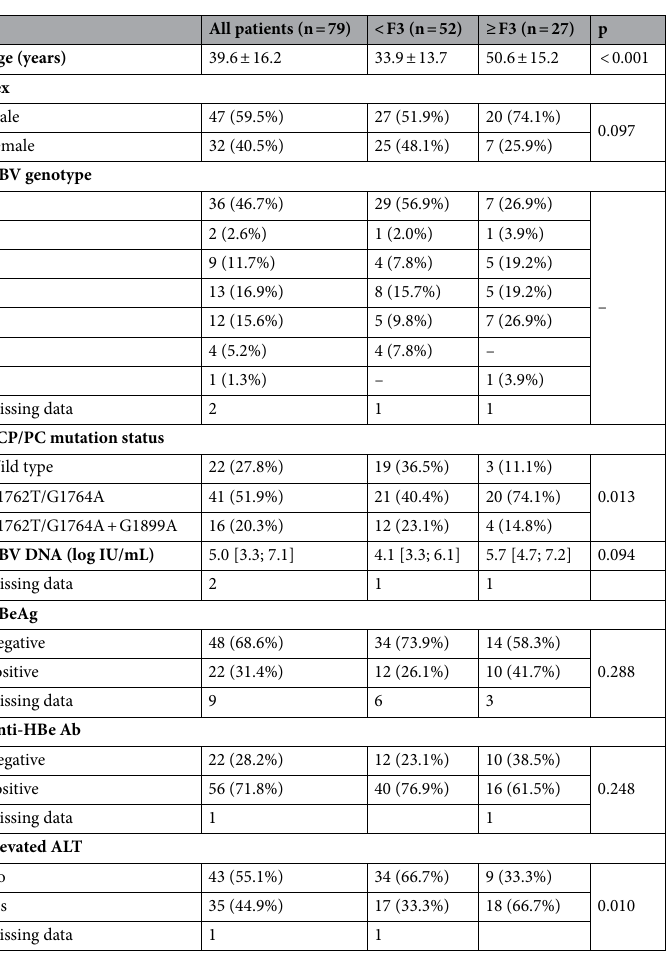
Table 1. Baseline characteristics of the enrolled patients (according to METAVIR liver fibrosis stage [< F3 vs. ≥ F3]). < F3 nonsevere fibrosis (F0–F2), ≥ F3 severe fibrosis (F3–F4), HBV hepatitis B virus, BCP basal core